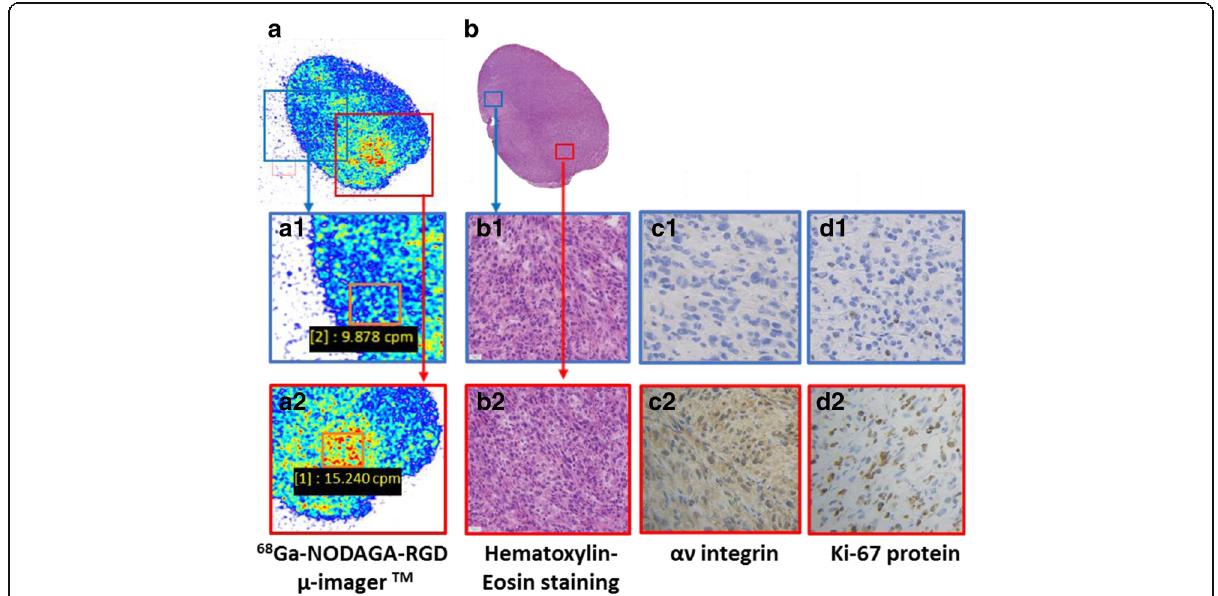
Fig. 6 Representative examples of ex vivo images obtained from the same glioblastoma tumor extracted from a nude mouse after sacrifice showing (1) the distribution of 68 Ga-NODAGA-RGD recorded by the μ Imager ™ and (2) with several immunohistochemical staining applied on contiguous slices for a morphological analysis (hematoxylin-eosin) and for analyzing the expressions of the α v subunit and the Ki-67 protein (an indicator of cell proliferation). Note that the expressions of the α v subunit (third panel c2 bottom) and of the Ki-67 (last panel bottom d2 right) protein appear much higher in a selected area showing a high level of recorded 68 Ga-NODAGA-RGD counts on the μ Imager ™ (15.240 counts-per-minute, images from the lower third of the figure; first panel bottom left), when compared with another area showing a low level of recorded counts (9.878 counts-per-minute, images from the middle third of the figure; first panel middle). By contrast, cell density appears equivalent in these two areas (second panel b1 and b2 middle and bottom) on the hematoxylin-eosin stained